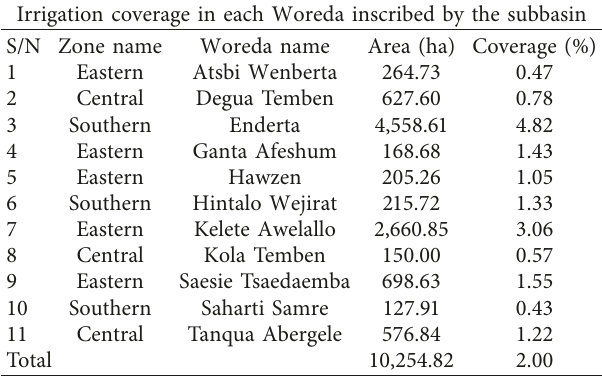
Table 5: Collected data of existing irrigated areas in the subbasin. Irrigation coverage in each Woreda inscribed by the